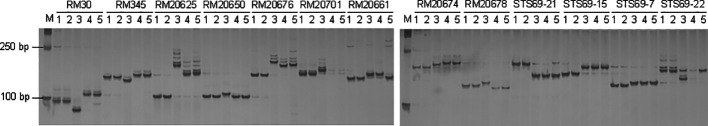
Confirmation of the origin of the introgression of the Pi69(t). Thirteen molecular markers linked with Pi69(t) were used to amplify the DNA fragments of the O. glaberrima (IRGC100137) donor parent (1), the introgression line IL106 (2), the recurrent parent DJY1 (3), and two indica cultivars: R498 (4), and Teqing (5). M, molecular weight marker DL2000. The PCR products were separated by 8% polyacrylamide gel.